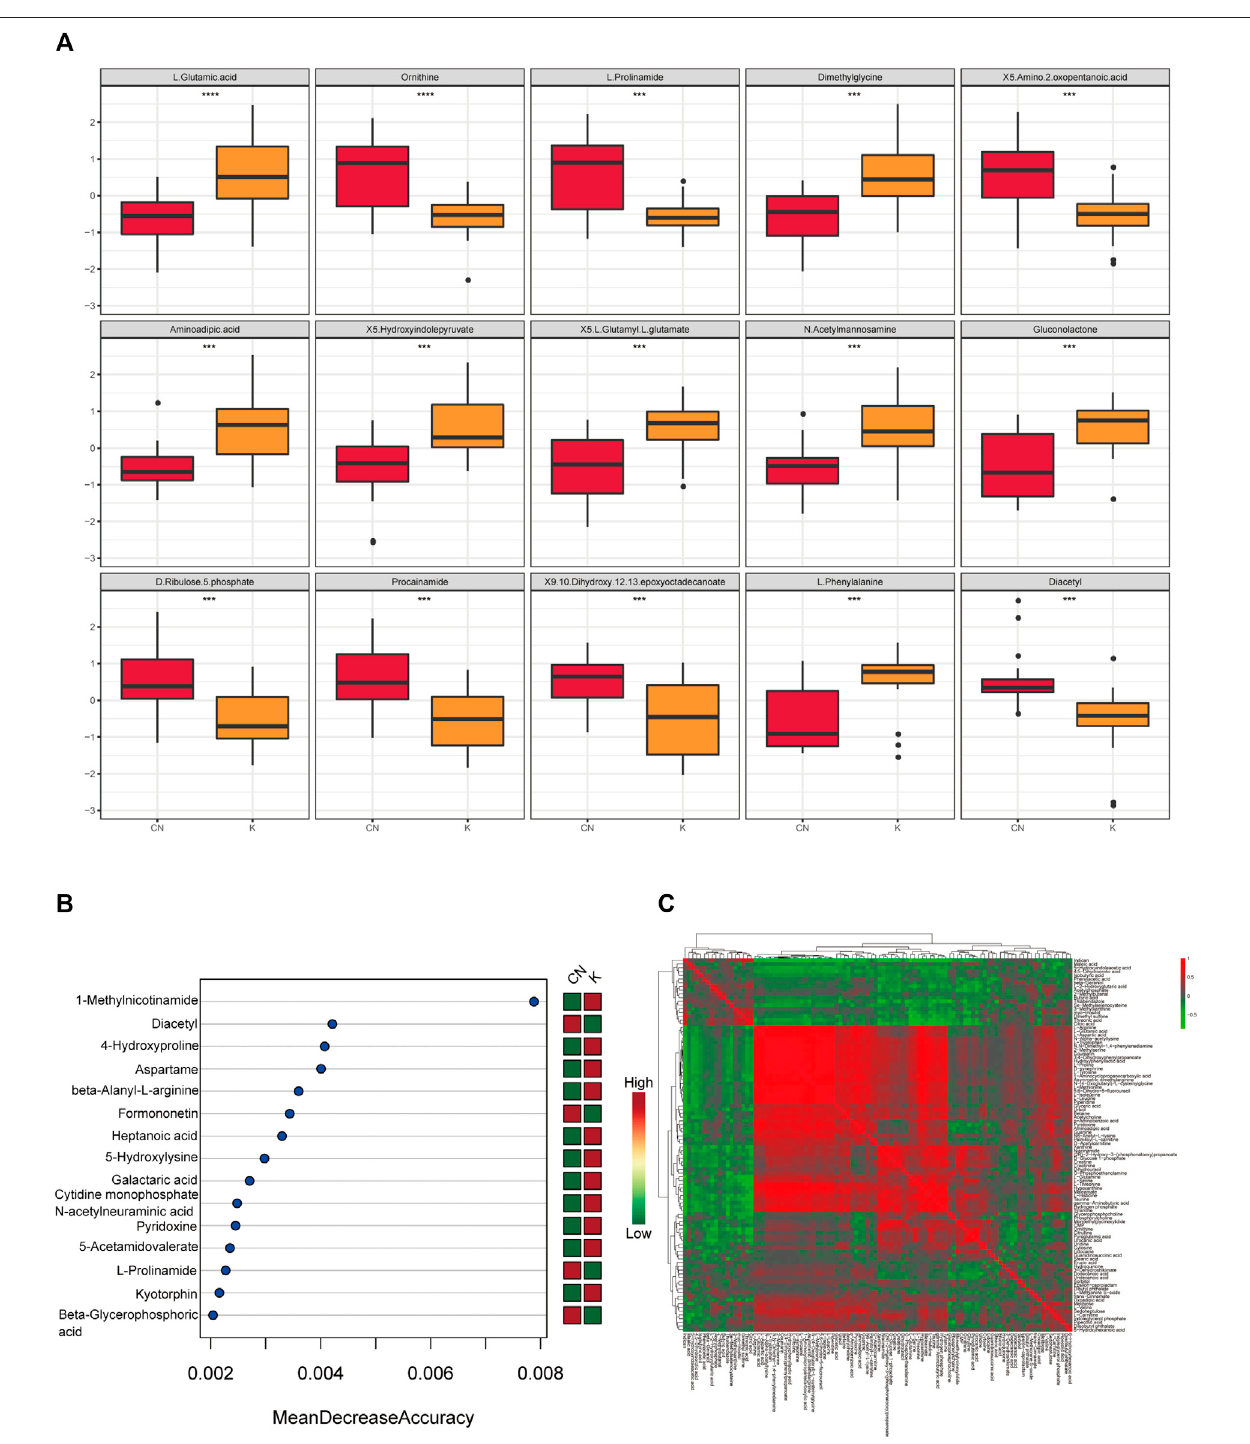
FIGURE5|(A) Boxdiagramofmetabolitedifferences.Tovisuallydisplaythedifferencesinmetabolitesbetweengroups,wemadeaboxdiagramofrepresentative differential metabolites with the top ranking (top 25 with small p value) obtained from one-dimensional statistical analysis. *, **, *** correspond to p < 0.05, p < 0.01, p < 0.001. (B) The 15 most important metabolites in random forests. The abscissa of the left fi gure is “ Mean Decrease Accuracy, ” which measures the importance of a metabolite in a random forest; the right fi gure is a heatmap of the content of metabolites in two groups. (C) Pearson correlation heatmap. Correlation coef fi cient matrix of the top 100 metabolites in total content. The correlation coef fi cient is represented by color: red is positively correlated, and green is negatively correlated.